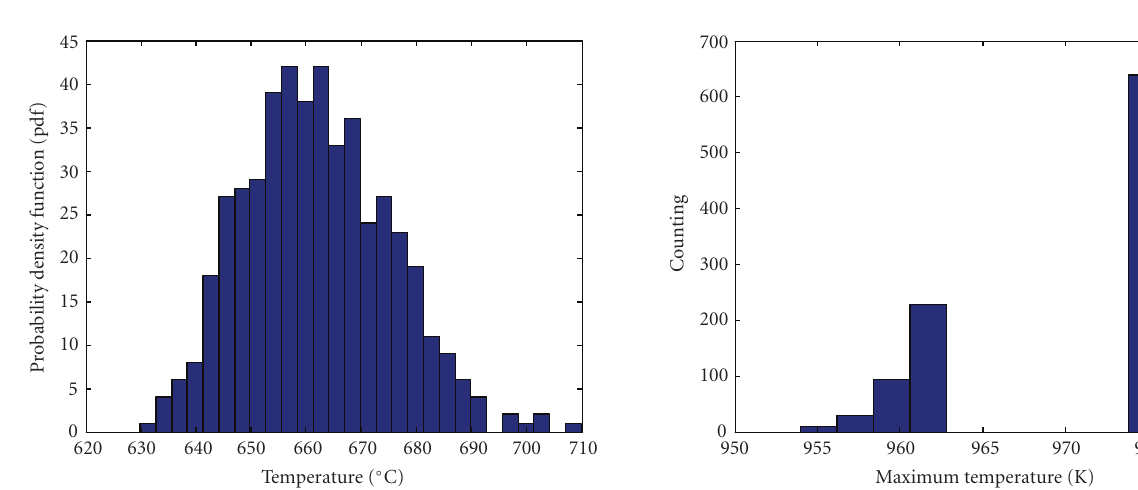
Figure 4: Hystogram constructed from 480 RELAP5/MOD3.2 sim- ulations.